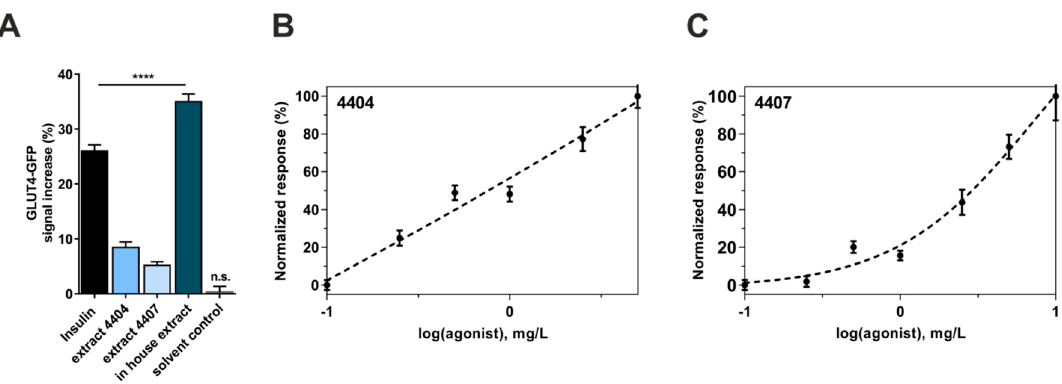
Figure 1. Effects of extracts prepared from Bellis perennis on GLUT4 translocation. ( A ) CHO-K1 GLUT4-myc-GFP cells were seeded in 96-well plates (35,000 cells per well), grown overnight followed by 3 h of starvation in Hank’s balanced salt solution (HBSS) buffer, and stimulated by insulin (100 nM) or extracts (1 mg/L) dissolved in Krebs Ringer phosphate HEPES buffer (KRPH) buffer for 10 min. Fluorescence was normalized to the value before insulin application. Error bars are based on the standard error of the mean ( n > 100, measured on 6 different days). **** p < 0.0001. ( B , C ) CHO-K1 GLUT4-myc-GFP cells were seeded in 96-well plates, grown overnight and then starved for 3 h in HBSS buffer followed by the addition of various Bellis perennis extract concentrations (10 min incubation time). A normalized dose-response curve was generated by measuring the increase in the green fluorescence protein (GFP) signal in the evanescent field after application of the indicated extract concentrations (4404 in ( B ) and 4407 in ( C )). Error bars are based on the standard error of the mean (SEM) ( n > 30, measured on 3 different days).